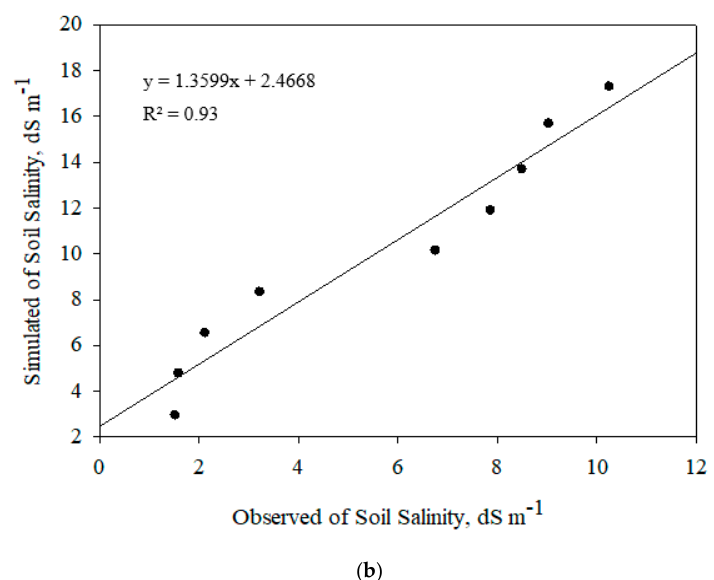
Figure 6. Correlation between observed and simulated data for ( a ) soil moisture and ( b ) soil salinity.